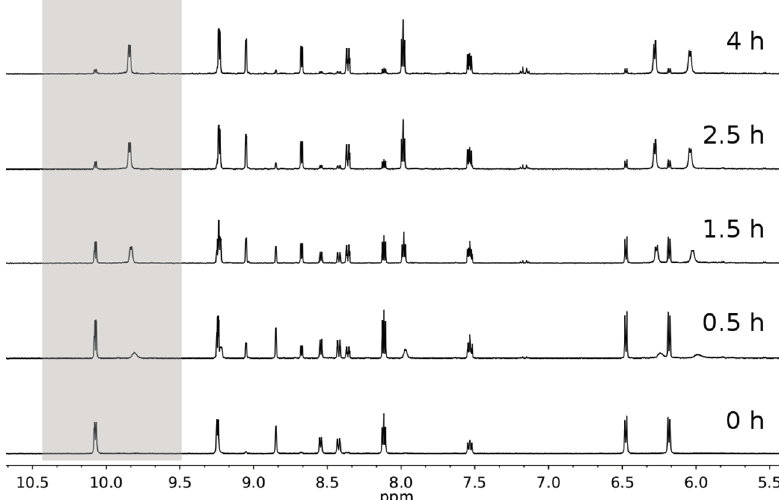
Figure 8. Photolysis ( λ exc = 400 nm, 2 mW·cm − 2 ) of complex 1 ( ca. 300 μ M) in aqueous solution (1%–5% DMSO) followed by 1 H-NMR spectroscopy. The grey panel